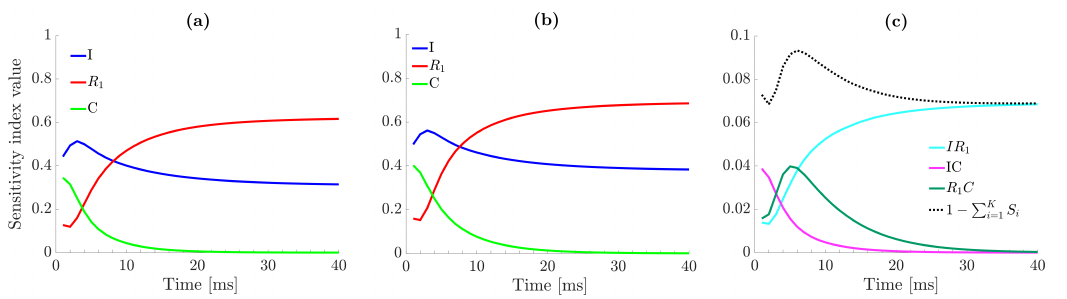
Figure 11. Time evolution of the first- ( a ), total- ( b ), and second- ( c ) order Sobol indices. R 2 and L are not reported since they always have null indices. Analysis of these plots provides the answer to Question